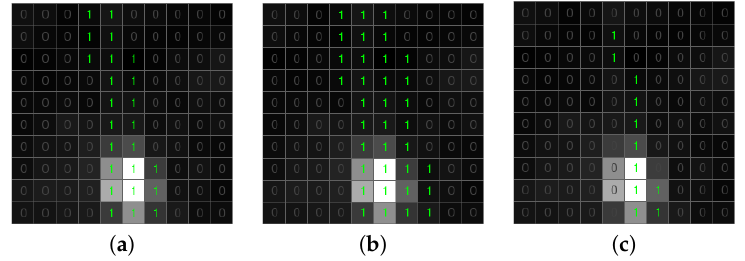
Figure 10. Morphological transformation of a positive candidate object. ( a ) Candidate object. ( b ) Dilation. ( c ) Erosion.